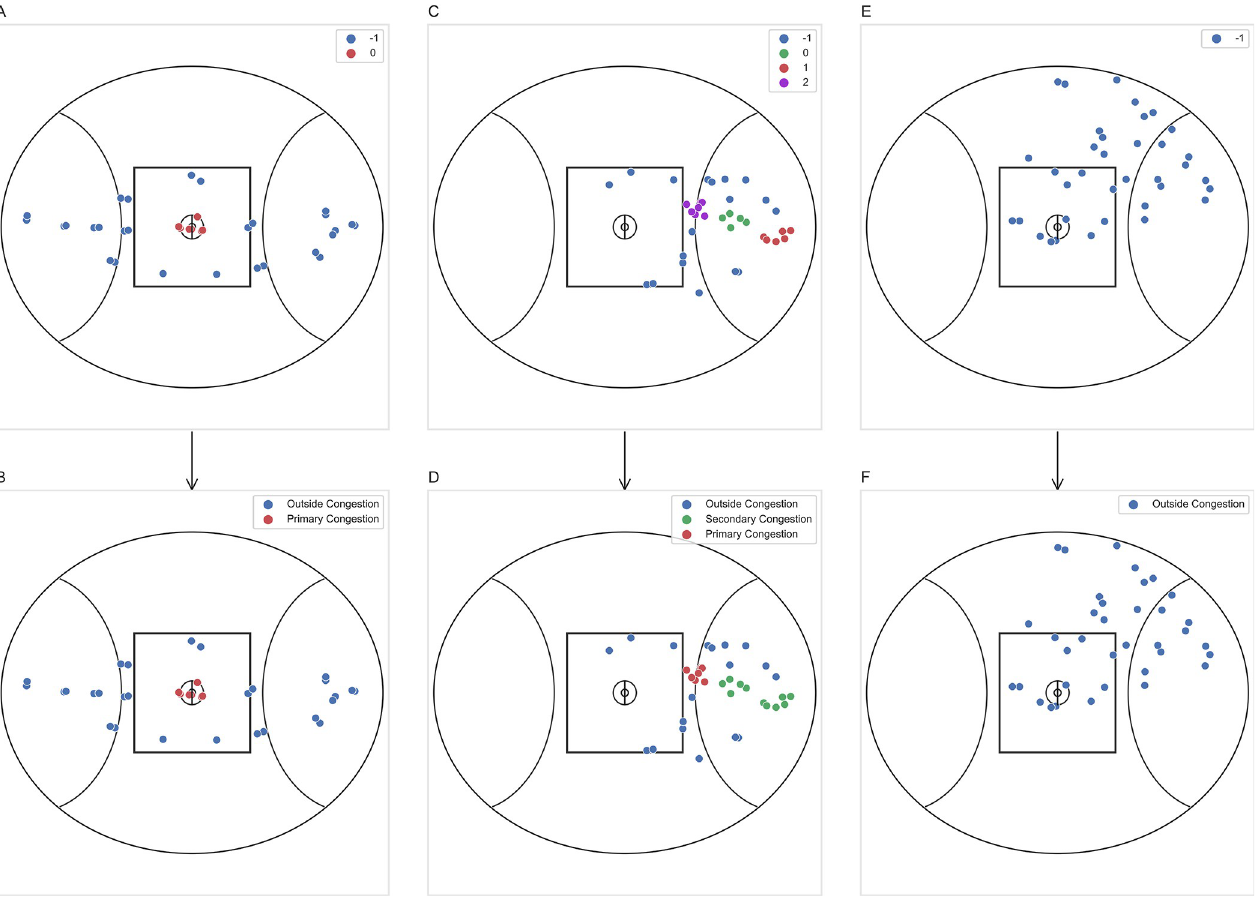
Fig 1. Players clustered as primary, secondary, or outside congestion during three separate time intervals during a match. Each column of subplots (A-B, C-D, E-F) are pairs representing the same time interval. Upper panel (A, C, E) represents initial output labels from the clustering model. Lower panel (B, D, F) displays the corresponding labels after translating into primary, secondary, and outside